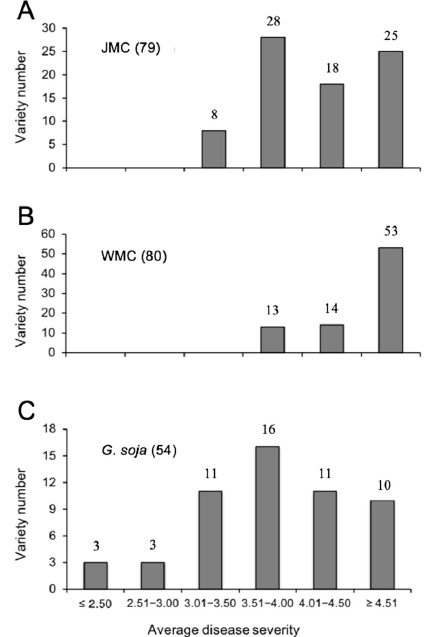
Figure 3. Frequency distribution of red crown rot severities in mini core collection from Japan ( A , JMC), and worldwide ( B , WMC) and wild soybean collections ( C ). Three replicates of 5 individuals of each accession were scored for disease severity after 14 days of inoculation with Calonectria ilicicola (UH2-1, 1%).